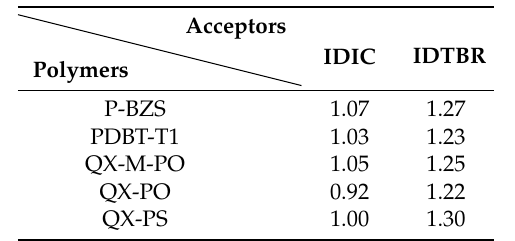
Table 3. The open voltage V OC (eV) of polymer/IDIC and polymer/IDTBR devices; where the conjugated unit of polymer n = 1.